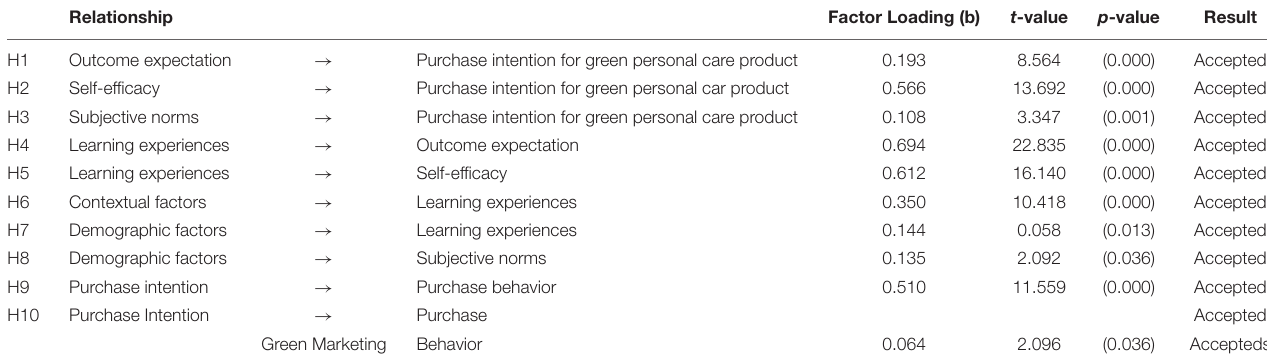
TABLE 6 | Result of hypothesis